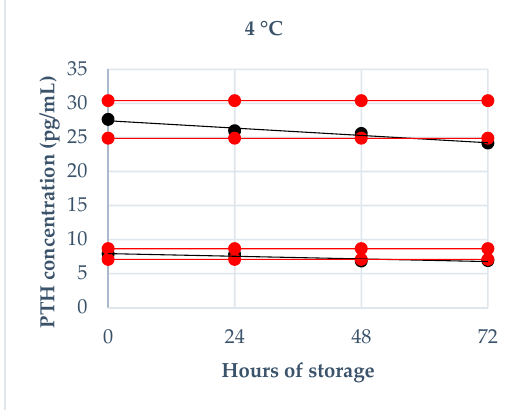
Figure 3. PTH stability at 4 °C during 72 h of storage (24 h, 48 h, 72 h): the black lines indicate the tendency of the obtained values; the red lines indicate ± 10% from the baseline value.